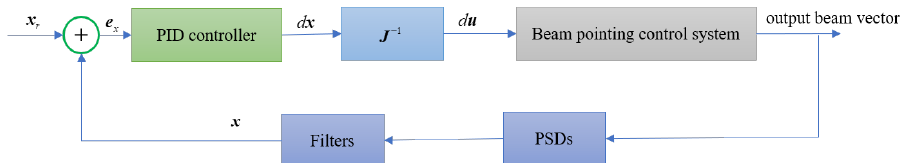
Figure 2. Block diagram of the beam pointing control system.